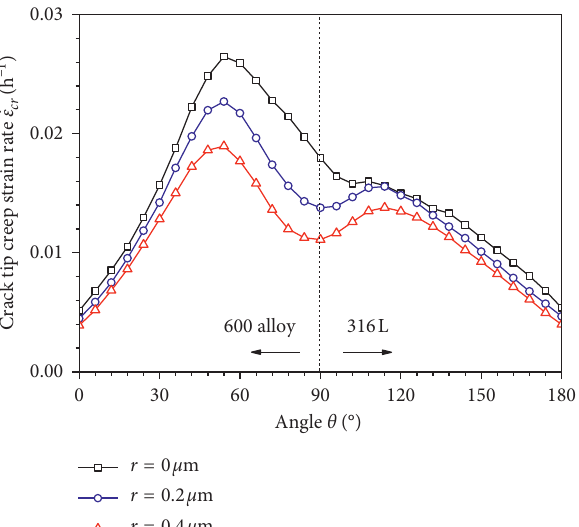
Figure 6: Creep rate of the crack tip without